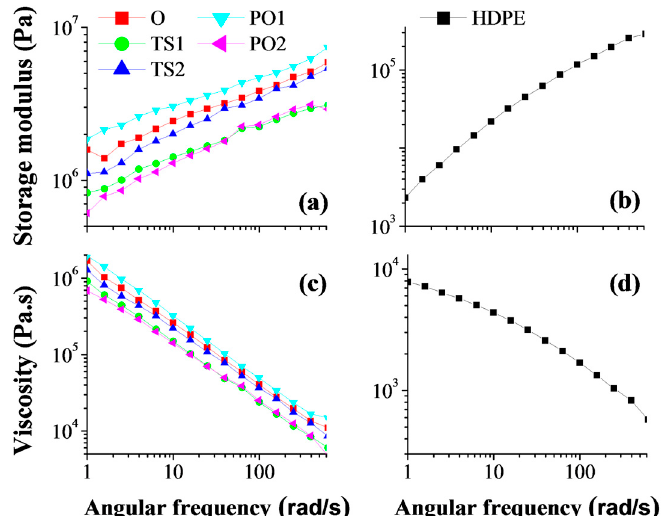
Figure 7. Storage modulus of ( a ) pulp fiber/HDPE composites and ( b ) neat HDPE; Complex viscosity of ( c ) pulp fiber/HDPE composites and ( d ) neat HDPE. Composite O: wet pulp fiber/HDPE mixture was dried by oven. Composite TS1: wet pulp fiber/HDPE mixture was dried by twin-screw extruder. Composite TS2: mixture TS1 was melt-extruded again. Composite PO1: wet pulp fiber/HDPE mixture was dried by prepressing and oven. Composite PO2: mixture PO1 was melt-extruded again.